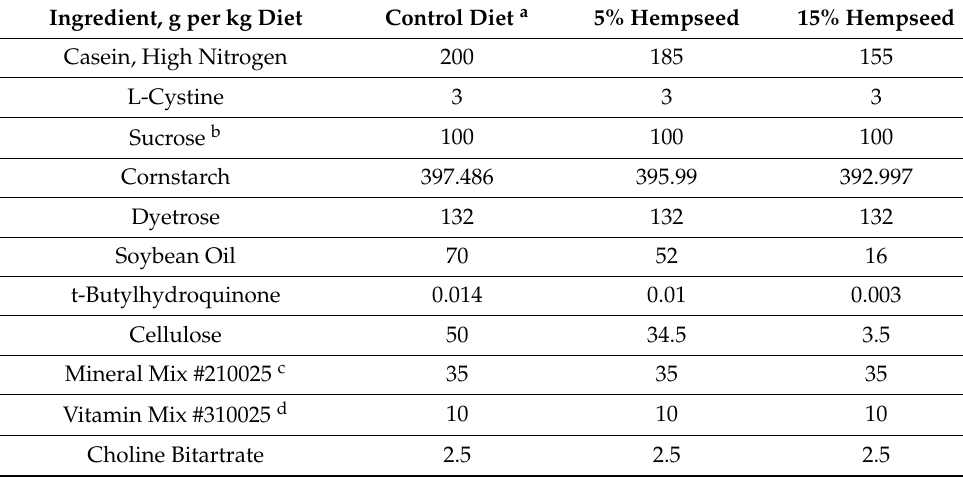
Table 1. Composition of experimental